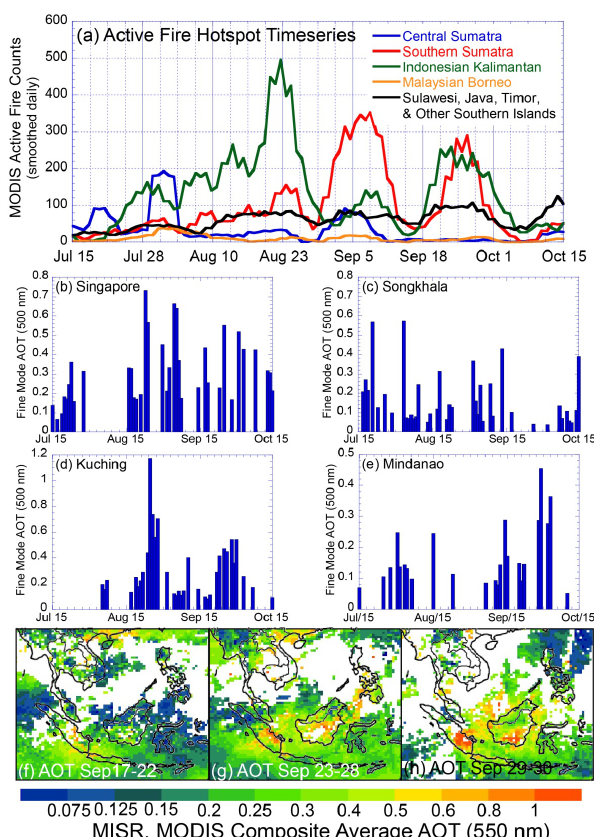
Figure 4. Contextual aerosol data for the 2011 aerosol season. (a) Combined MODIS active fire hotspot prevalence by region. Data is smoothed in a 5-day boxcar filter to help account for orbit. (b– e) . Level 2 AERONET 500nm fine mode AOTs for key sites in the Southeast Asian region (marked on Fig. 2b). (f–h) Combined MODIS 7 MISR satellite AOT analysis for the early, mid and late phases of the